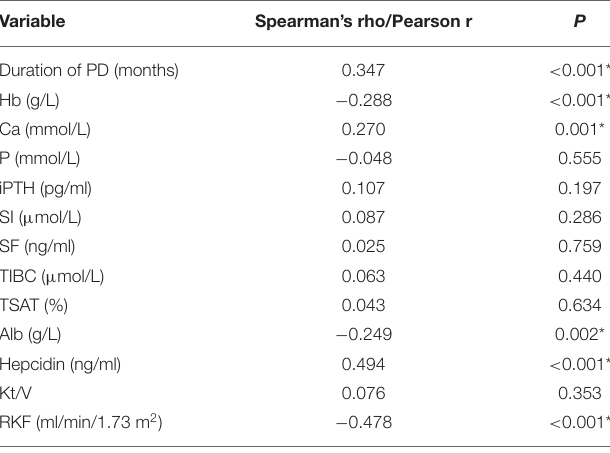
TABLE 4 | Correlation analysis of factors associated with the IRLS score in patients undergoing PD.